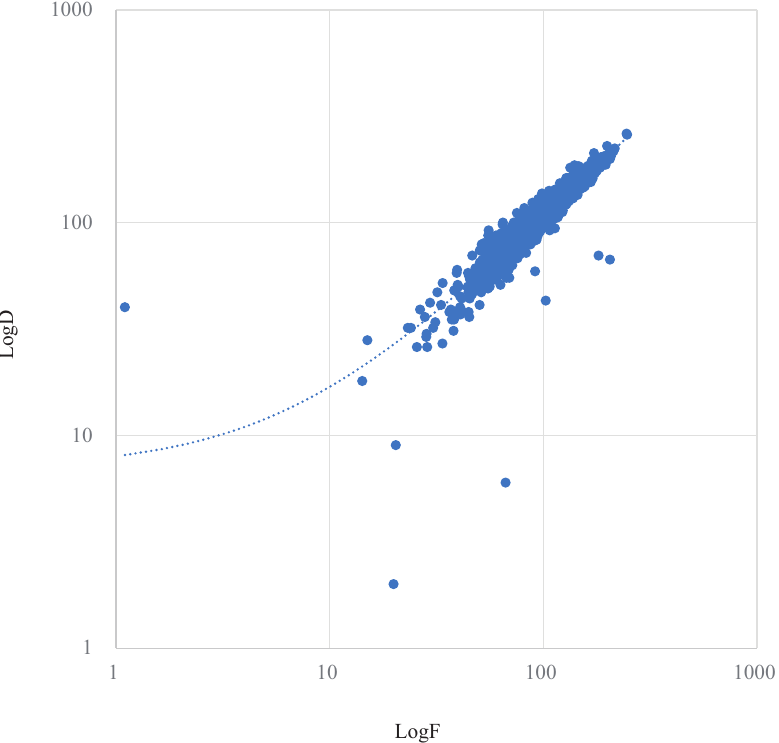
F i g ure 1. Relationship of the lo g transformation v al u e bet w een direct meas u rement of LDL- cholesterol and calc u lated LDL-cholesterol u sin g the Friede w ald eq u ation in the ran g e of < 400 m g /dL tri g l y ceride (n =